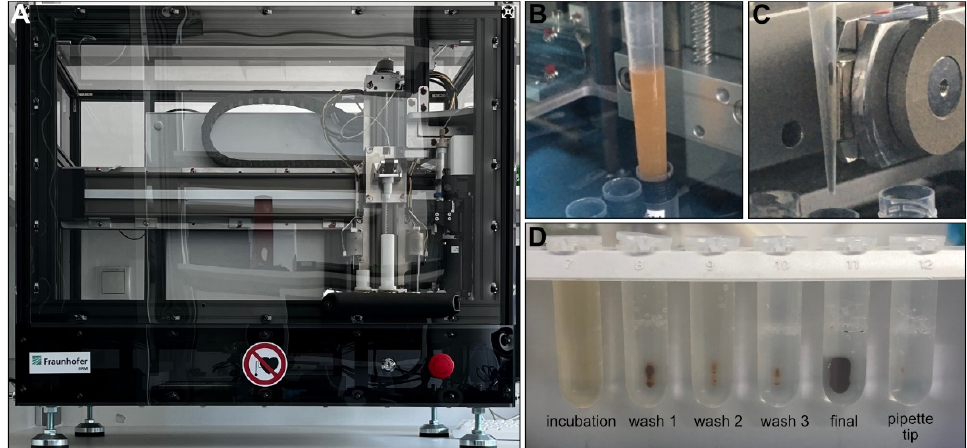
Figure 3. IsoMAG-ONE10.0 device used for immunomagnetic isolation of tetraspanin-positive EV populations from urine ( A ). Sample incubation with antibody-coated beads under constant mixing ( B ). Retaining antibody-coated beads with captured EVs from the sample using a strong magnet automatically moved directly to the outside of the tip ( C ). FluidX tube contents were assessed for bead loss in the magnetic rack after assay completion ( D ).